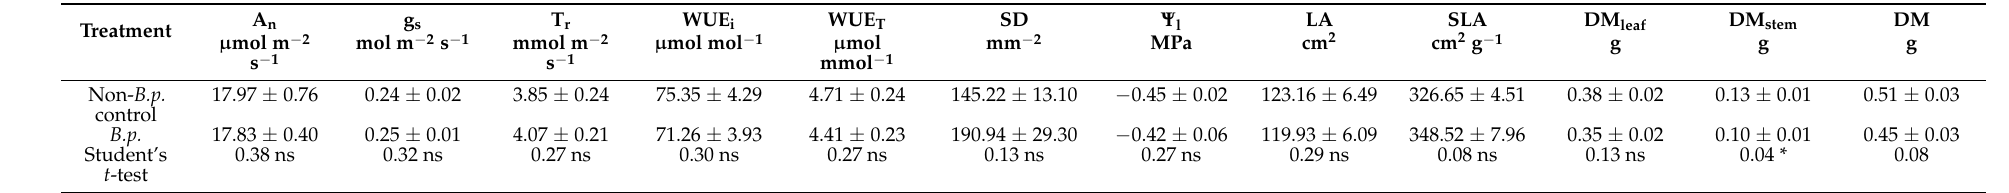
Table 1. Photosynthetic rate (A n ), stomatal conductance (g s ), transpiration rate (T r ), intrinsic water use efficiency (WUE i ), instantaneous water use efficiency (WUE T ), stomata density (SD), leaf water potential ( Ψ l ), leaf area (LA), specific leaf area (SLA), dry matter of leaf (DM leaf ) and stem (DM stem ) and total dry matter (DM) as affected by Bacillus pumilus ( B.p. ) inoculation at first harvest, when all plants grew 2 weeks after irrigated to field capacity. Non- B.p. control means plants free from B.p. inoculation. The data in the table were expressed as mean ± standard error (SE), n = 4. Student’s t -test was applied. * indicates significance level at p < 0.05; ns denotes no significance.